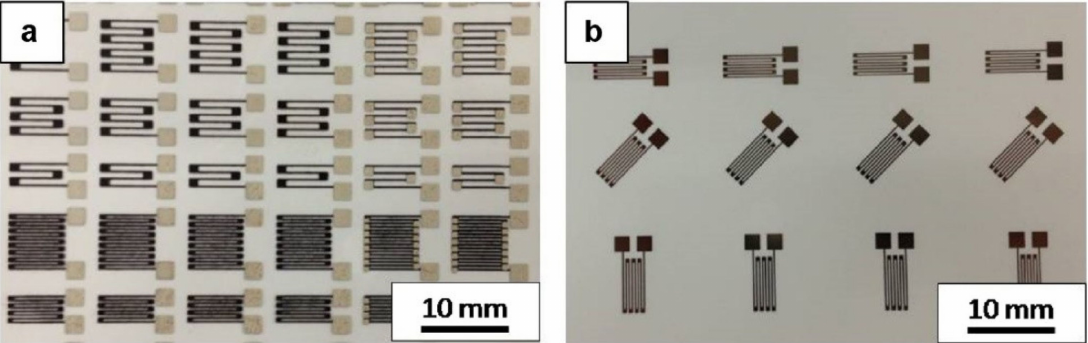
Figure 8. Serpentine sensing patterns deposited on PET substrates using ( a ) screen-printing and ( b ) inkjet-printing process